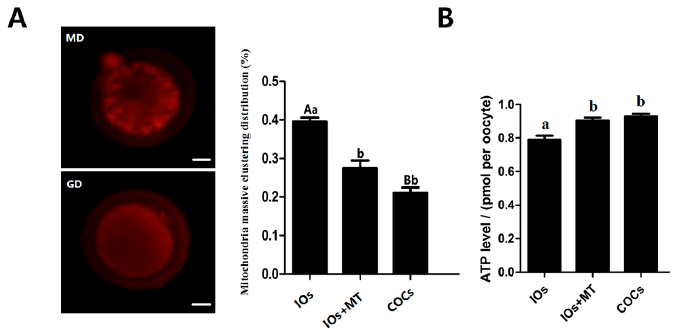
Figure 3. Effects of melatonin on mitochondria distribution and ATP production in MII-stage oocytes. ( A ) The state of mitochondria distribution, (mean ± SEM of 87 oocytes). The red fluorescence represents mitochondria. MD: the representative image of mitochondrial massive clustering distribution. GD: the representative image of mitochondrial granulated distribution; scale bar = 20 μ m; the bar graph was the statistical analysis of the mitochondrial distribution in oocytes; ( B ) Cytoplasmic ATP levels in individual MII bovine oocytes (mean ± SEM of 85 oocytes). a,b Values of different superscripts indicate significant difference ( p < 0.05); A,B Values of different superscripts indicate highly significant difference ( p < 0.01).